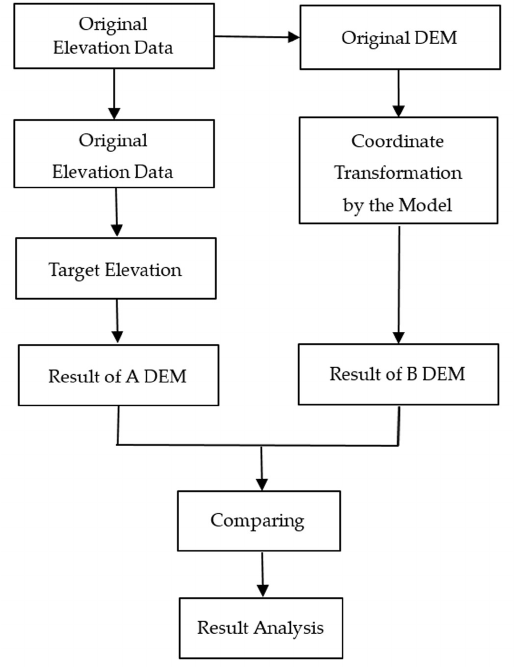
Figure 7. The error of resampling elevation Figure 5. The flow of experimental analysis. Based on the experiment, it proved that the source of DEM coordinate conversion error mainly comes from the error of resampling elevation. The resampling error is illustrated in Figure 7. Point A and B in Figure 7 correspond to two adjacent grid centres, and AB line is the slope after fitting. c, c' and c'' are possible resampling positions, and Δc, Δc' and Δc'' are resampling errors in elevation corresponding with c, c' and c'' positions. Obviously, the elevation resampling error is mainly affected by the terrain slope and the panning quantity